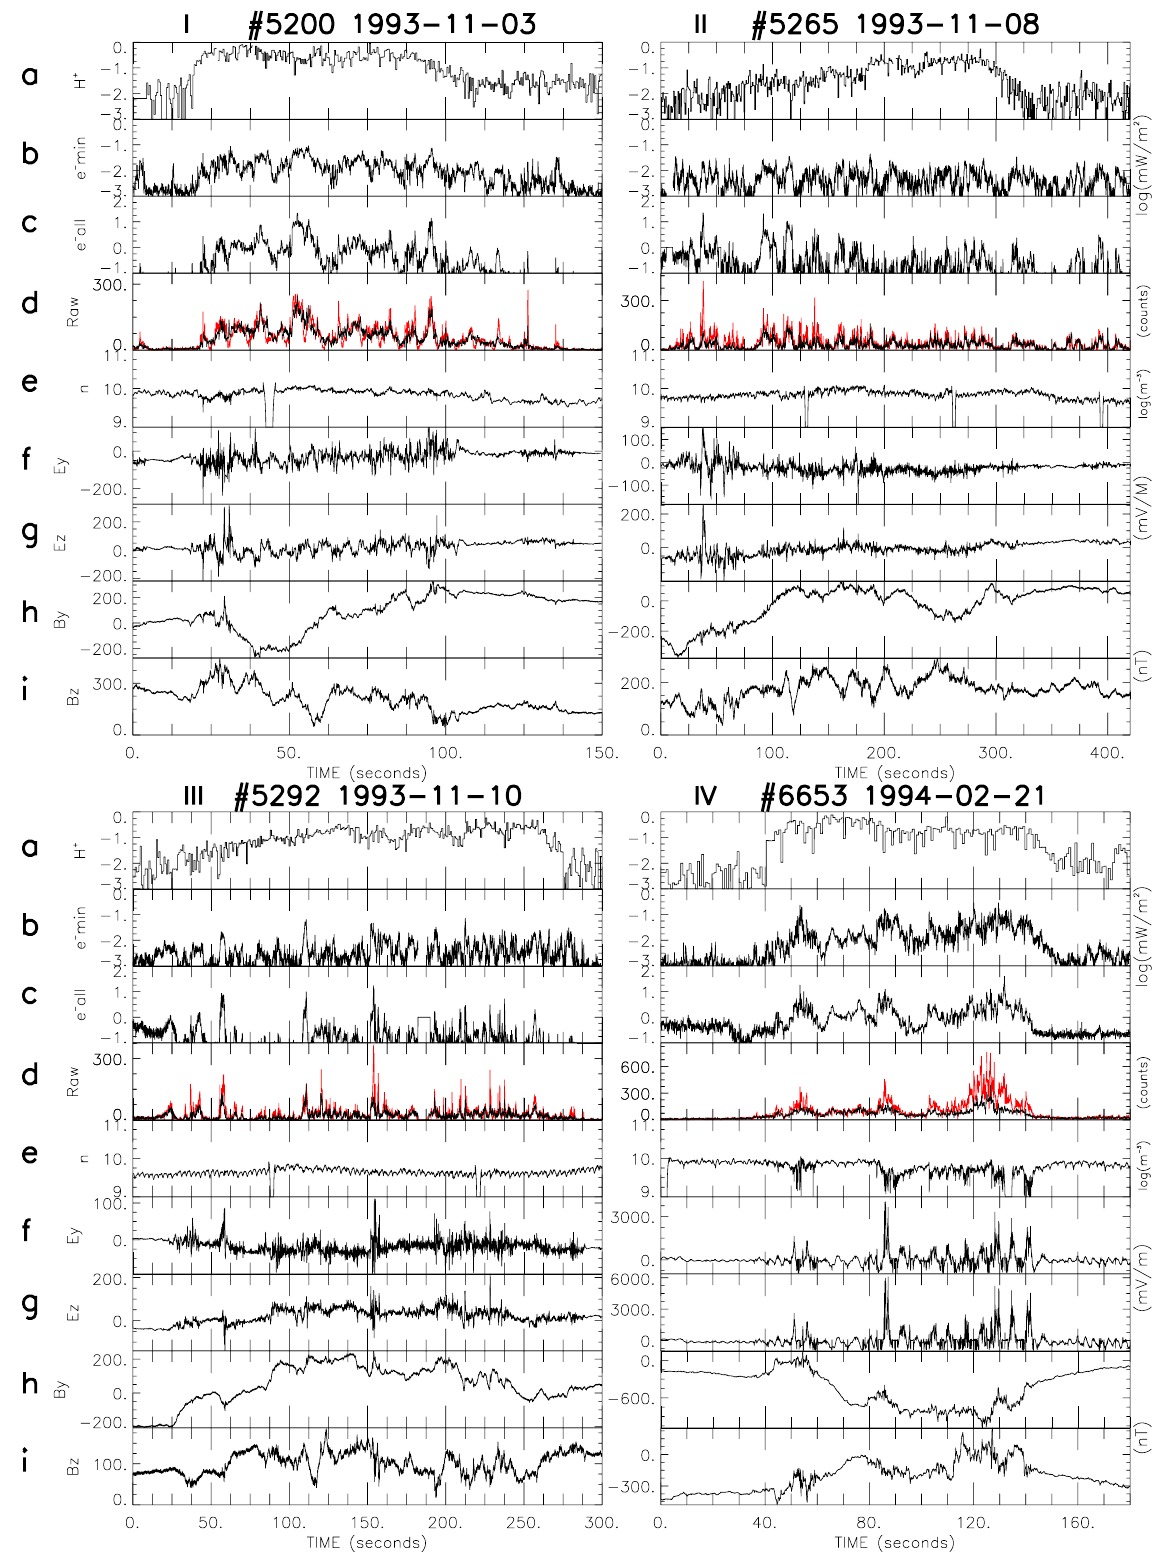
Fig. 2. Data from the same four Freja satellite passes as shown in Fig. 1. The panels show from the top; proton (50eV–4.3keV), electron (12–50eV) and electron (36eV–25keV) downward energy fluxes (mW/m 2 ); the total electron counts for two different pitch-angles (0 ◦ red and 90 ◦ black); the Langmuir probe measured density; the DC electric and magnetic fields perpendicular to the model magnetic field lines. In panel (b) to (d), small data gaps can be